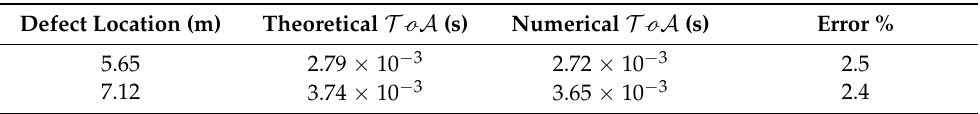
Table 3. Comparison of theoretical and numerical time of